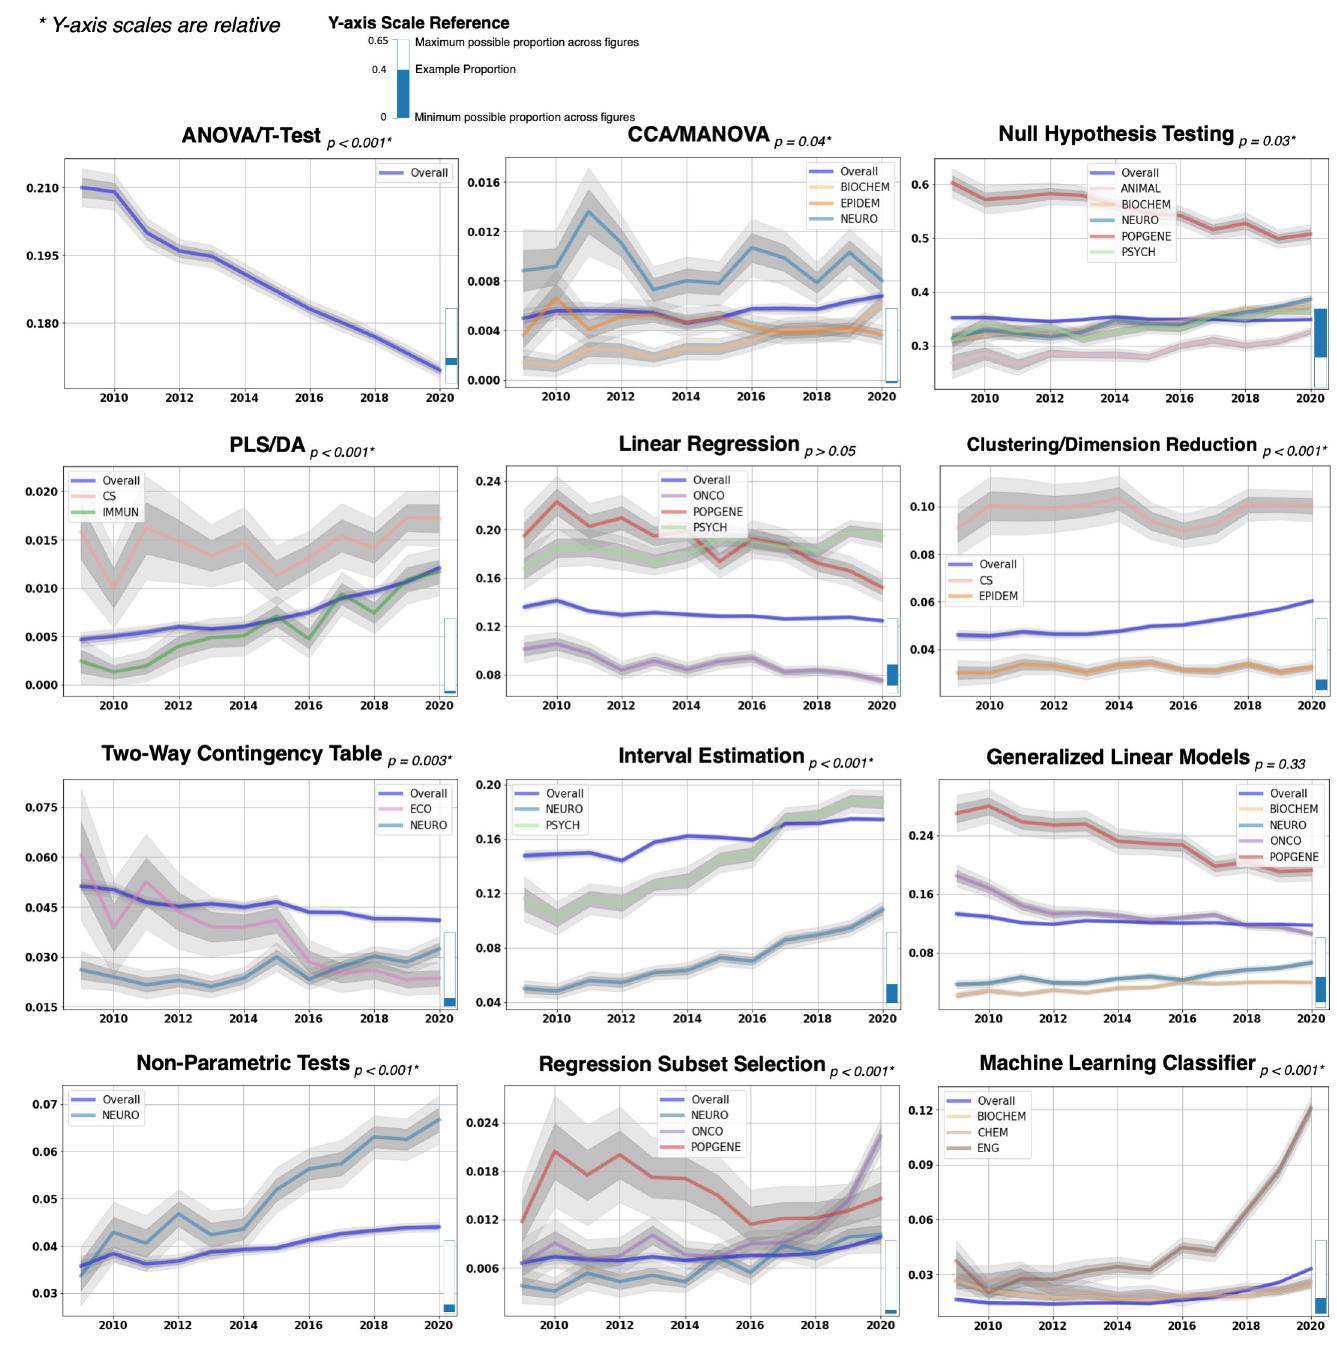
Fig 4. A decade of analytic method trends (2009–2020). Time series of 12 analytic method categories from 2009 to 2020 (annual frequency). For each analytic method category, the time series represents the proportion of articles that contained a mention of that category in their “Methods/Materials” or “Results” section per year. The time series of each analytic method category is displayed in its own plot with different y-axis scales. Note that because each plot differs in y-axis scale, caution should be observed when comparing trends across categories. To help readers compare y-axis scales across categories, we have provided a y-axis scale bar in the bottom right of each figure. An illustration of the y-axis scale bar is presented at the top of the figure. The height of the bar corresponds to the distance between the minimum possible proportion (0) and the maximum possible proportion (0.65) of all articles per year across all categories. The highlighted region of the bar (in blue) corresponds to that categories’ range of proportion values (across years) from 0 to 0.65. Random sampling variability for each proportion estimate was visualized using bootstrapped SEs from 100 bootstrapped samples of articles at each time point (dark shaded region: ± 1 SE, light shaded region: ± 2 SE). Overall, analytic methods taught in introductory research methods and statistics courses (e.g., t test/ANOVA, 2-way contingency tables, and linear regression) have shown differing